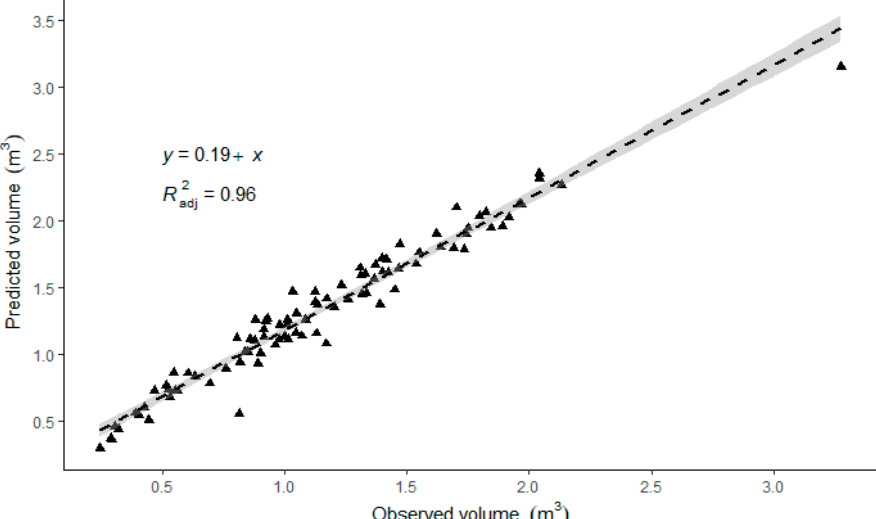
Figure 3. Relationship between the volumes (m3) estimated with the parameterized Riemer´s equation and field measurements of Pinus radiata stands in Ñuble Region (South, Chile). The linear model of this relationship (dashed line), the coefficient of determination, and the fitted model equation are shown. The gray shading around the line represents the 95% confidence interval.